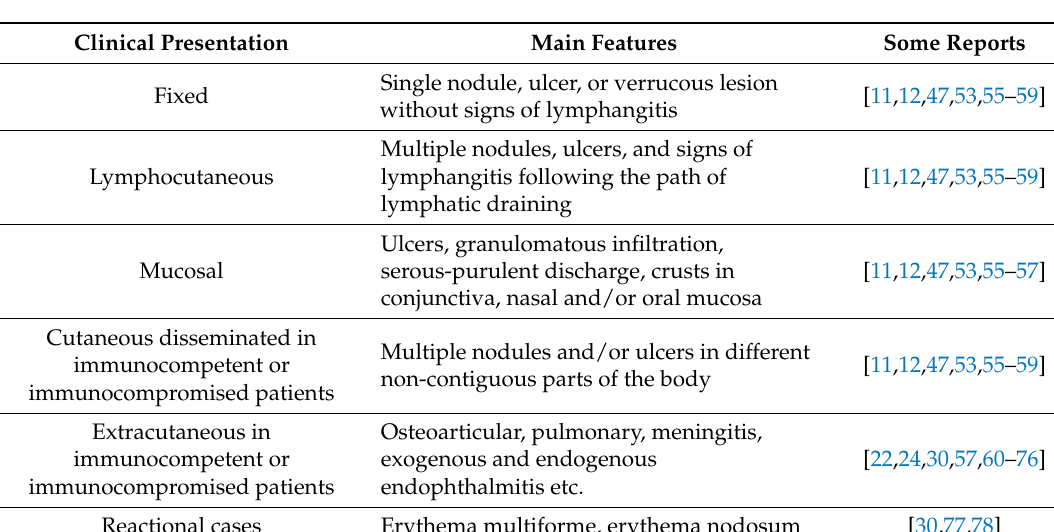
Table 1. Clinical presentation of human sporotrichosis.